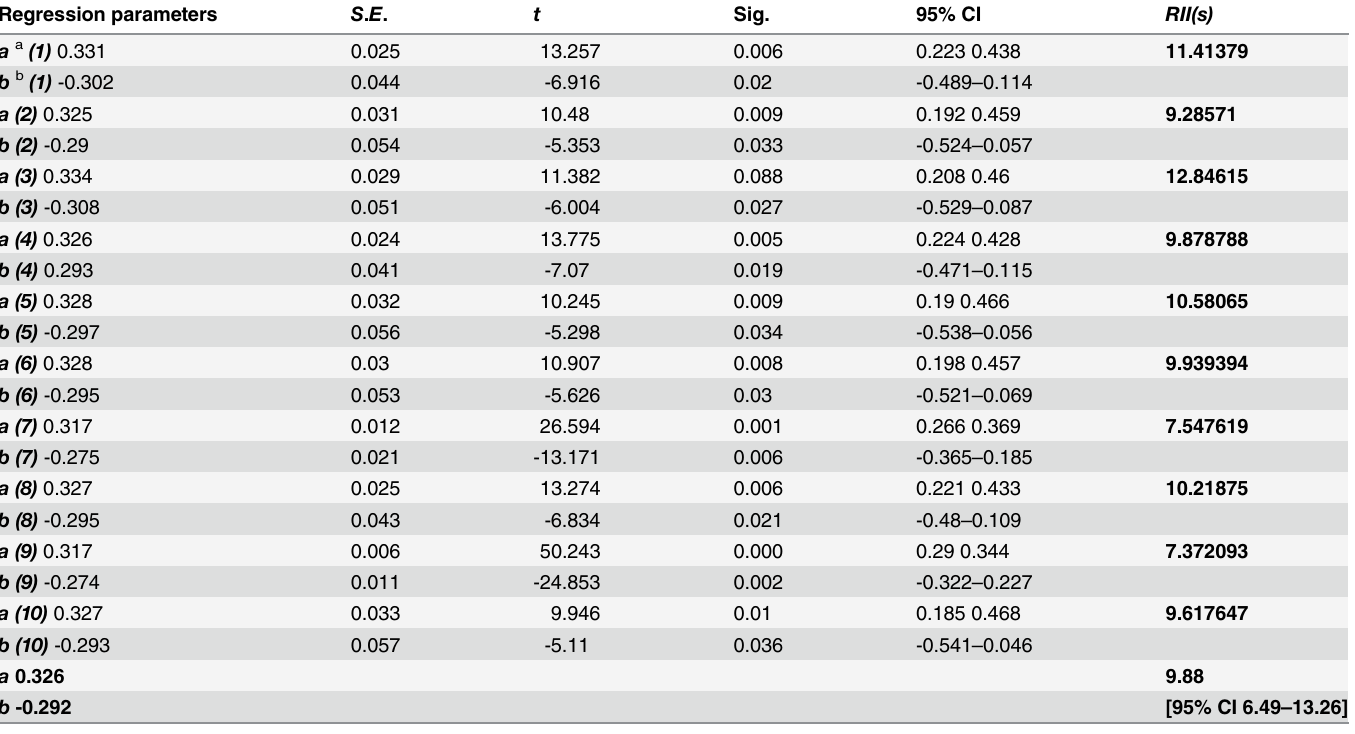
Table 4. Results of least squares linear regression analysis on imputed data, imputed RIIs and final RII . Regression